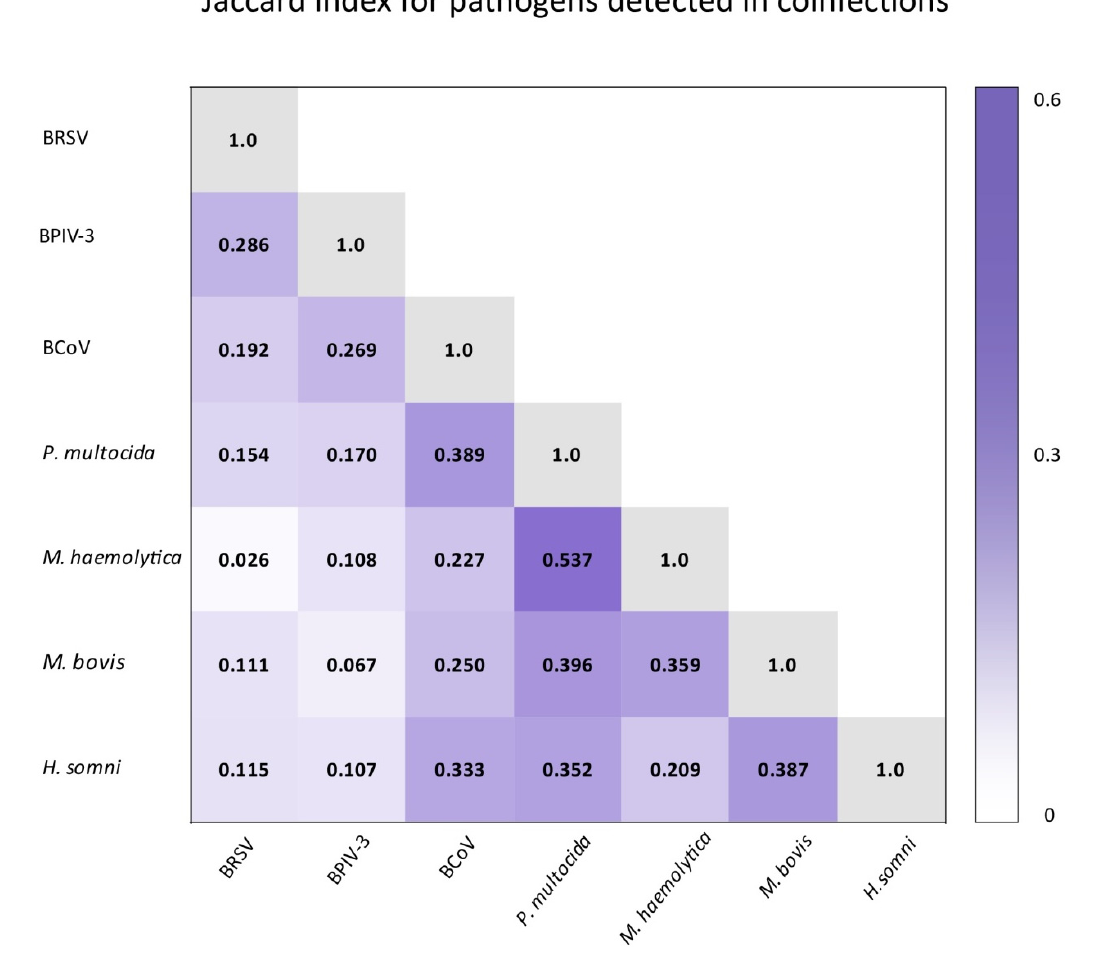
Figure 8. Matrix of Jaccard similarity coefficients (Jaccard index) between all pathogens detected in coinfections. The darker the color, the higher the value of the Jaccard index.